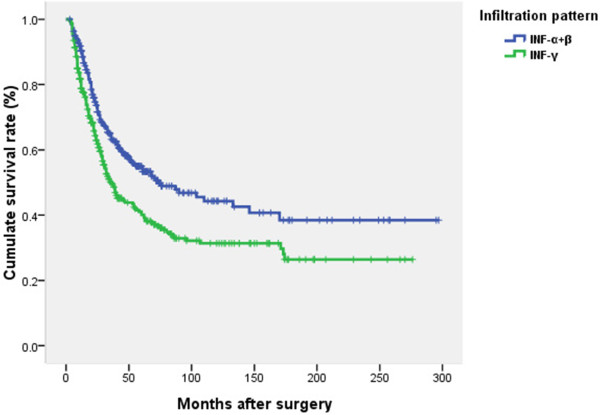
Survival curves in relation to the tumor infiltrating growth pattern. Prognosis worsened abruptly in patients with INFγ compared to patients with INFα or β. The difference was significant (χ2 = 14.42, P < 0.01) using log rank test.